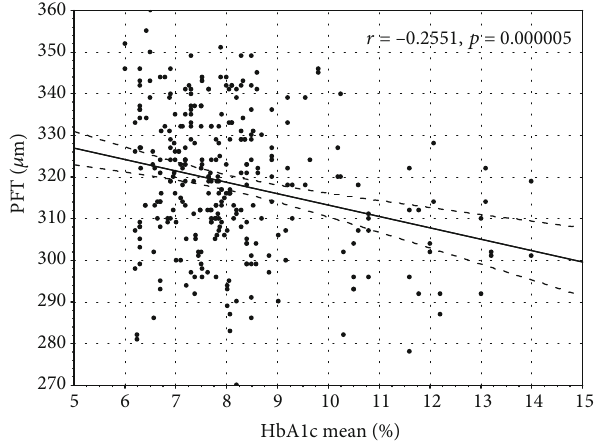
Figure 1: The correlation between current glycated hemoglobin A1c and foveal thickness.